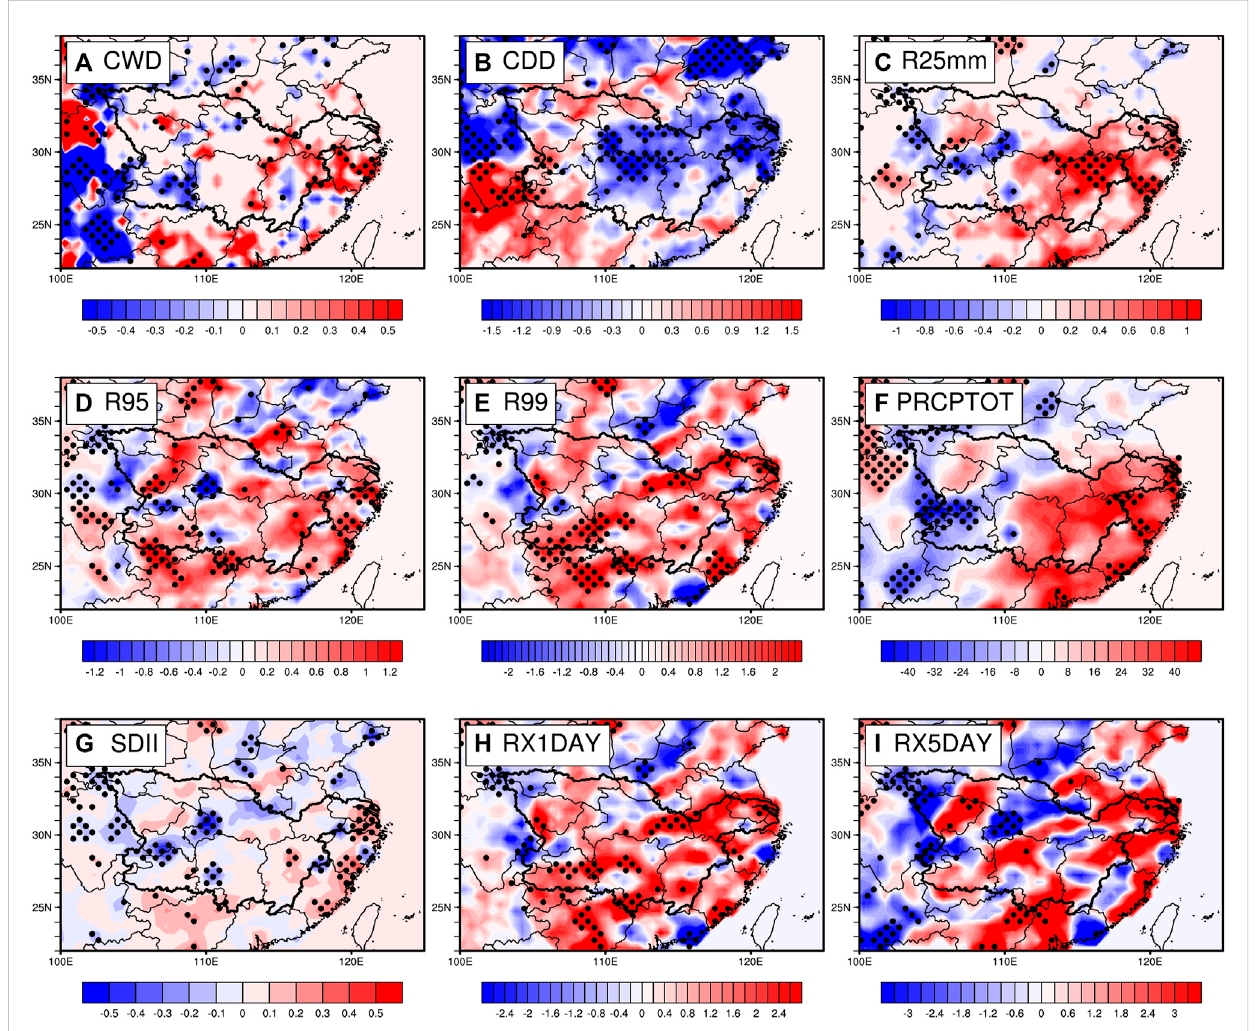
FIGURE 4 Spatial distributions of the variation tendency of annual mean precipitation indices over the MLYR from 1979 to 2015. The area surrounded by the thickblacklineistheMLYR.Thedottedareasareindicatedtopassthe95%con fi dencetest. (A) CWD; (B) CDD; (C) R25mm; (D) R95; (E) R99; (F) PRCPTOT; (G) SDII; (H) RX1DAY; (I)